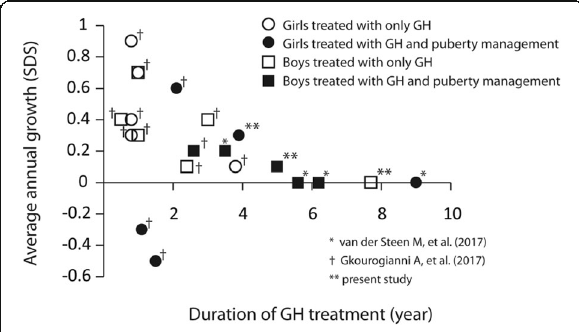
Fig. 4 Average annual change in the SDS of height in subjects with ACAN p. Gln2364Pro variant receiving GH